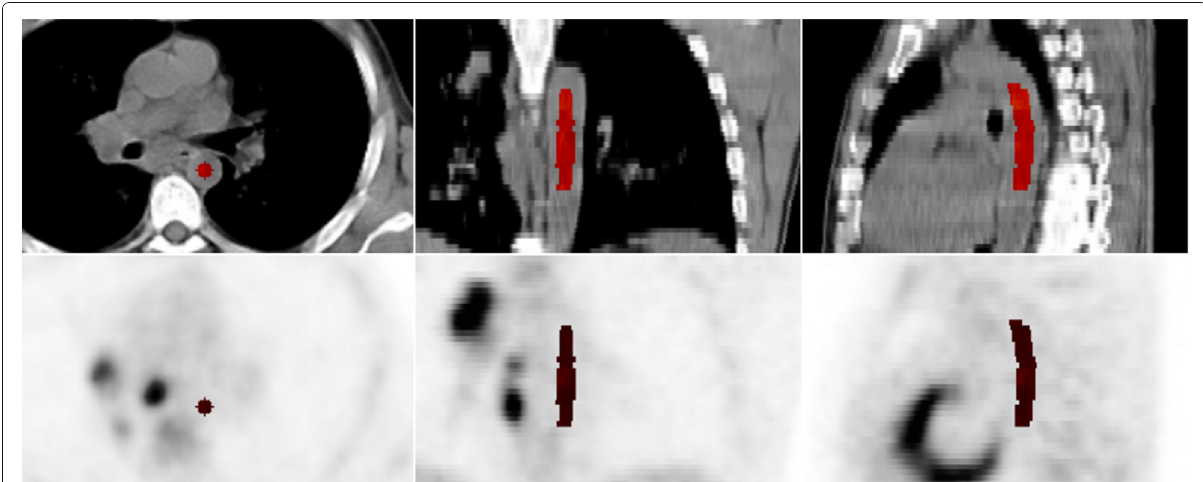
Fig. 1 Example of a valid aorta ROI delineation (highlighted in red) observing the prescription described in the “Materials and methods” section